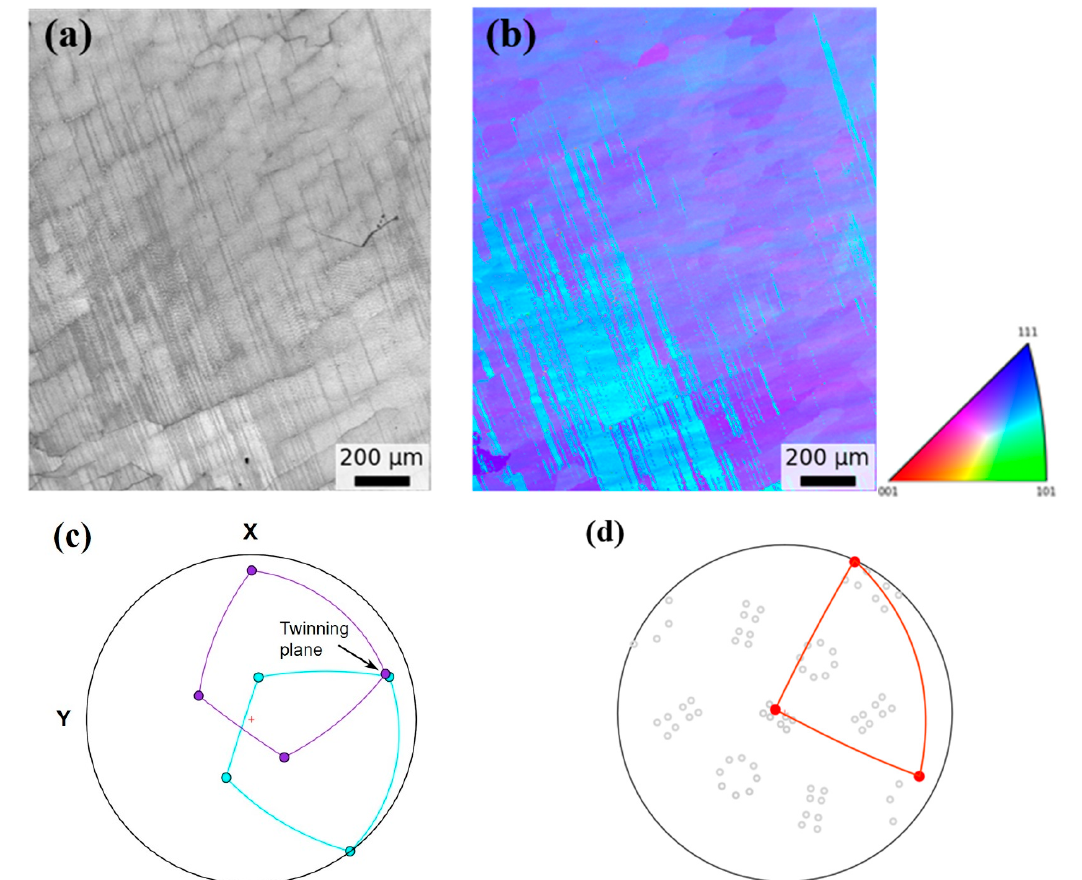
Figure 6. EBSD results on the plane normal to the growth direction for 0° oriented sample. ( a ) image quality, ( b ) corresponding orientation image (IPF-y), ( c ) {111} γ pole figure of two twin related variants in ( b ), ( d ) {001} β pole figure showing reconstructed orientation of β phase based on orientation relationship.